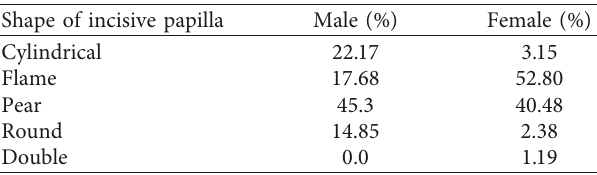
Table 2: The percentages of different shapes of incisive papilla in Jordanian adults.